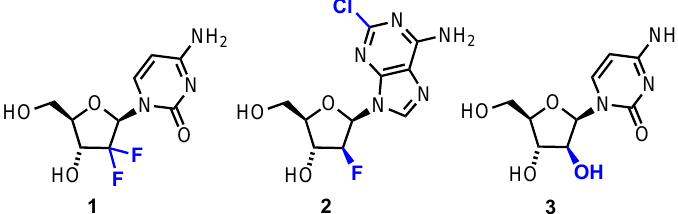
Figure 1. Gemcitabine 1 , clofarabine 2 and Ara-C 3 . Modifications compared to native d - ribo -configured purine or pyrimidine nucleosides are shown in blue.